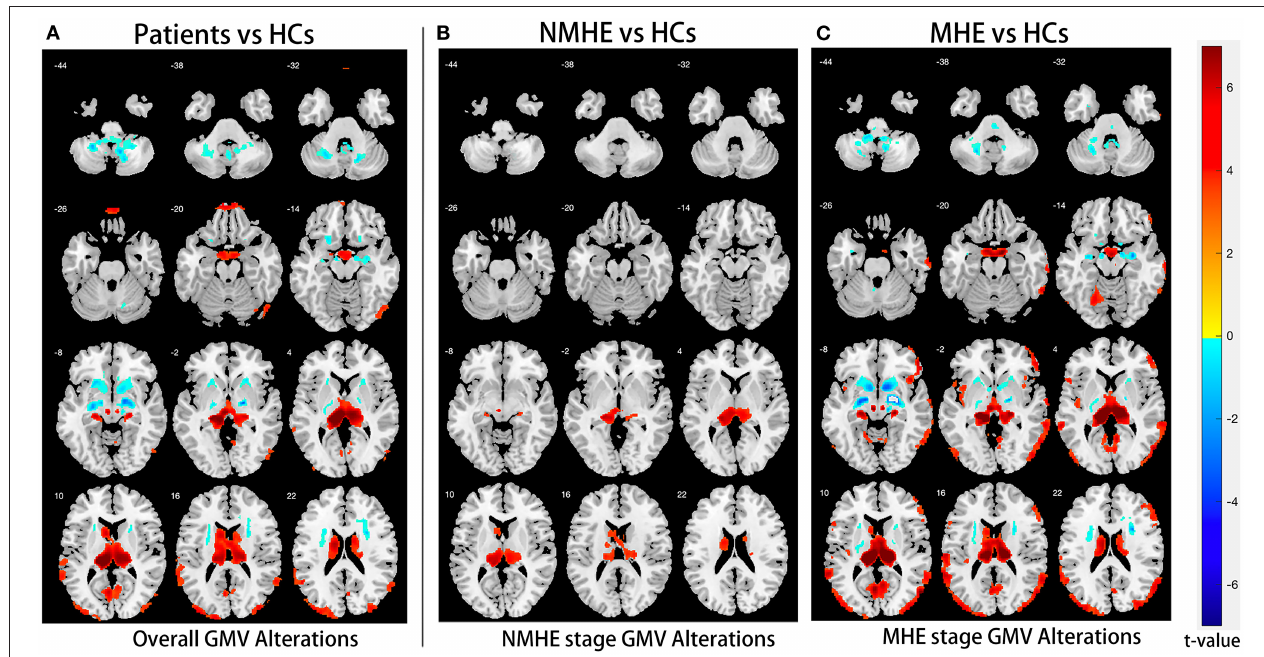
FIGURE 2 | Overall and stage-specific gray matter alterations. Overall GM alterations in all cirrhotic patients mainly involved the cortex-basal ganglia-thalamus (CxBGTh) circuit and the thalamus–cerebellum circuit compared to HCs ( A , false discovery rate [FDR] < 0.01). Meanwhile, stage-specific GM alteration started from the bilateral thalamus and the left caudate in the NMHE stage (compared with HCs, FDR < 0.05) (B) , extending to other regions of the CxBGTh circuit and the thalamic-cerebellum circuit (including the bilateral basal ganglia, the bilateral cerebellum, and the cortex) in the MHE stage (compared with HCs, FDR < 0.05) (C) . The t -values were represented by the colors shown in the color bar. GM, gray matter; HCs, healthy controls; NMHE, patients without MHE; MHE, minimal hepatic